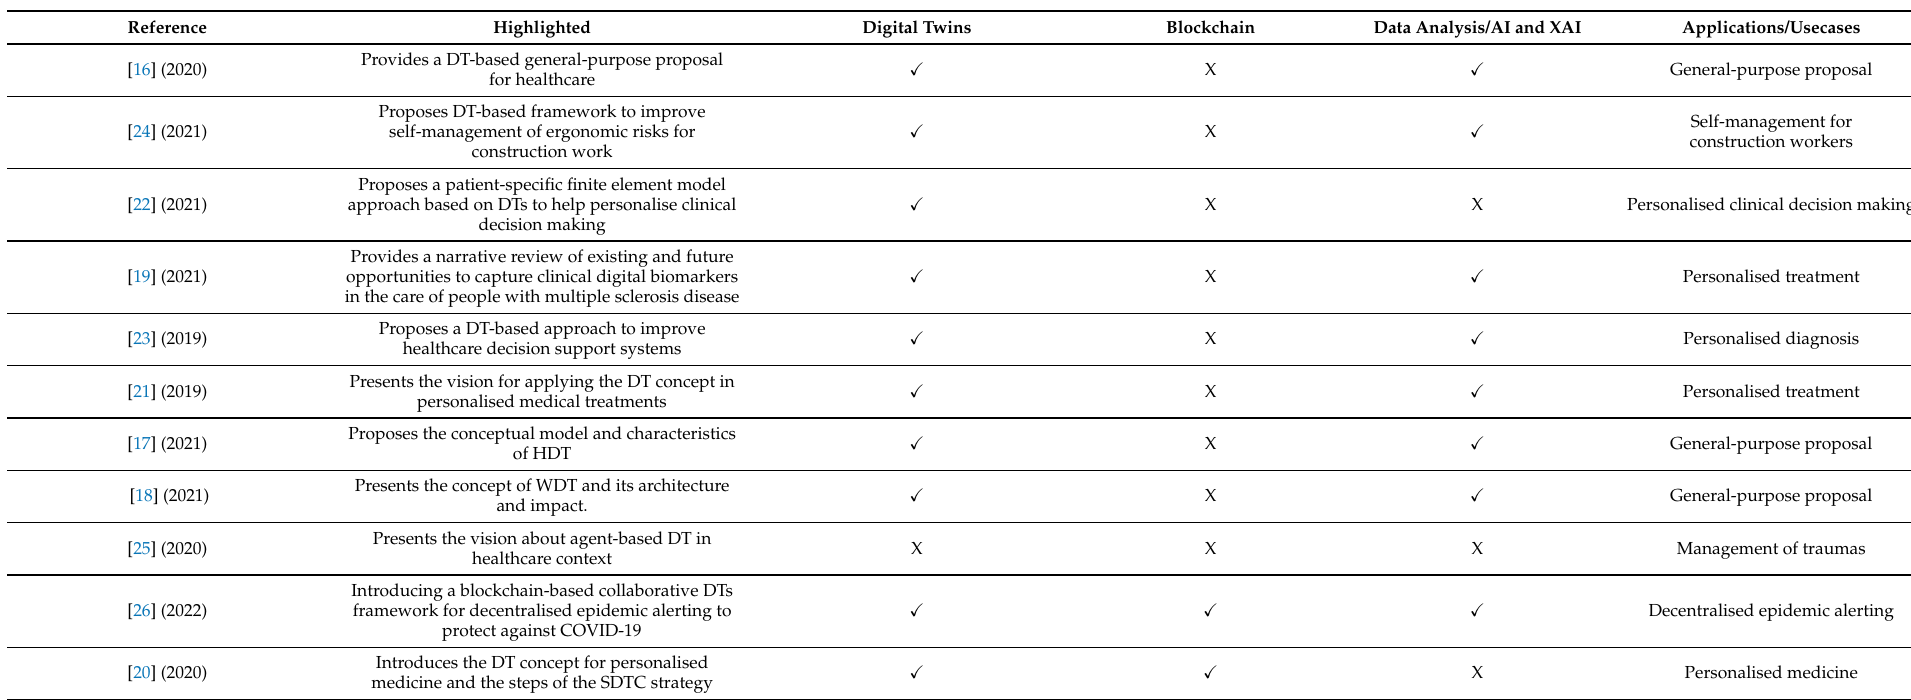
Table 2. Comparison of the previous works and our current proposed work with respect to the technologies used.